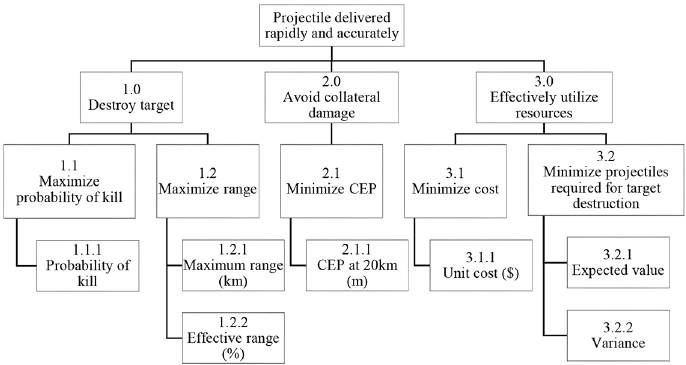
Figure 3. Value hierarchy for the army ’ s long-range artillery